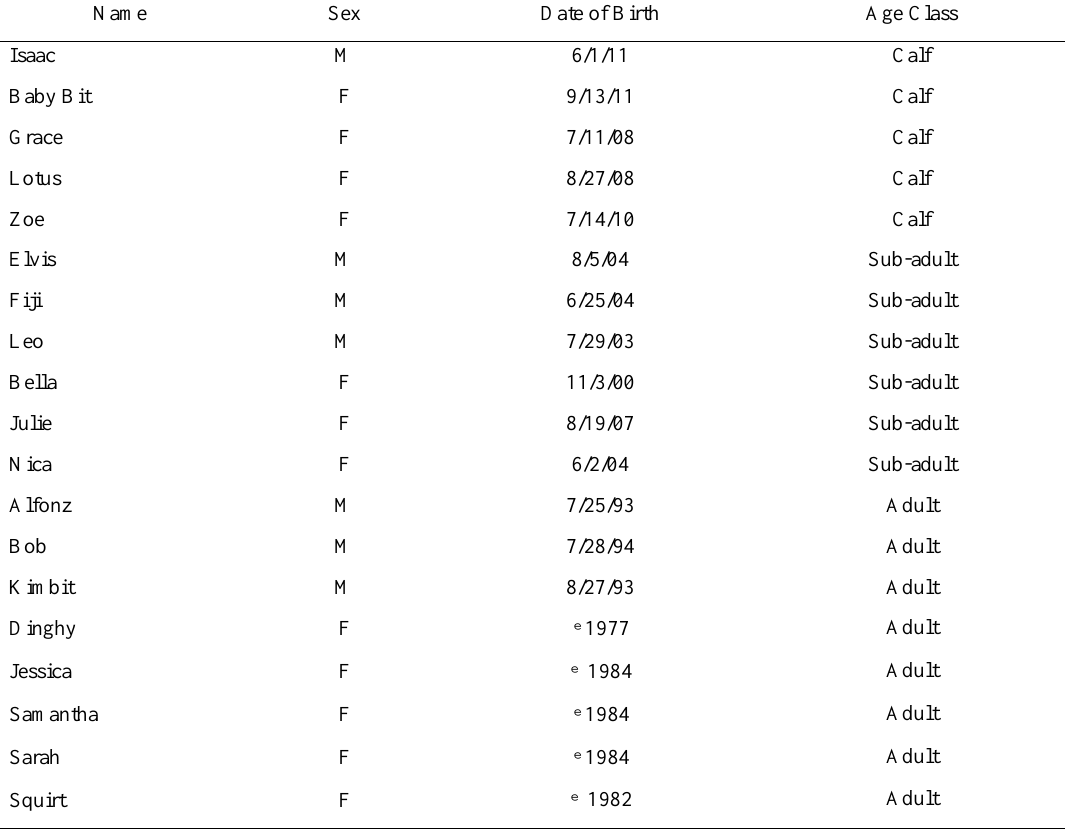
Demographics of the Study Population. Two Animals (Isaac and Baby Bit) were born during the Study Name Sex Date of